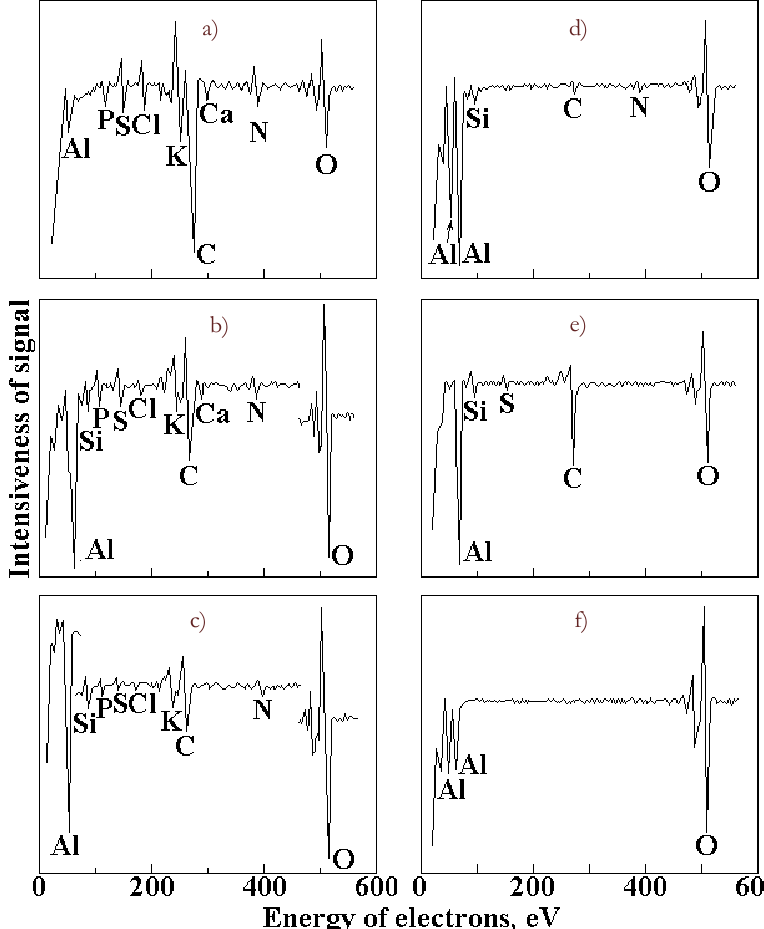
Figure 6: OG’e- spectres made from fracture surfaces of specimens of AVT Al-based alloy for (a) the initially performed fracture surface, after its removing under ions Ar+ during (b) 15 min, and 45 min for (c) zones-1, and (d) zones-2; (e) and (f) for zones-1 and zones-2 respectively but reproduced by the pike of